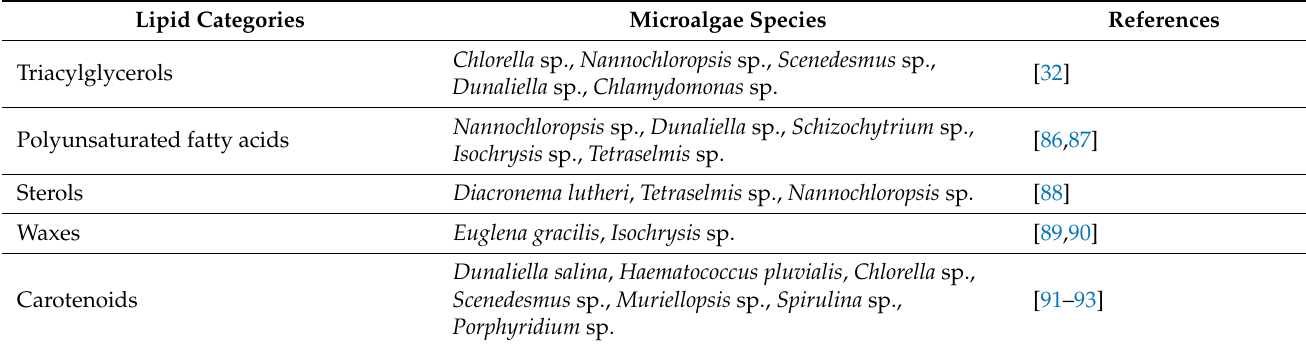
Table 3. Microalgal species and related lipid categories